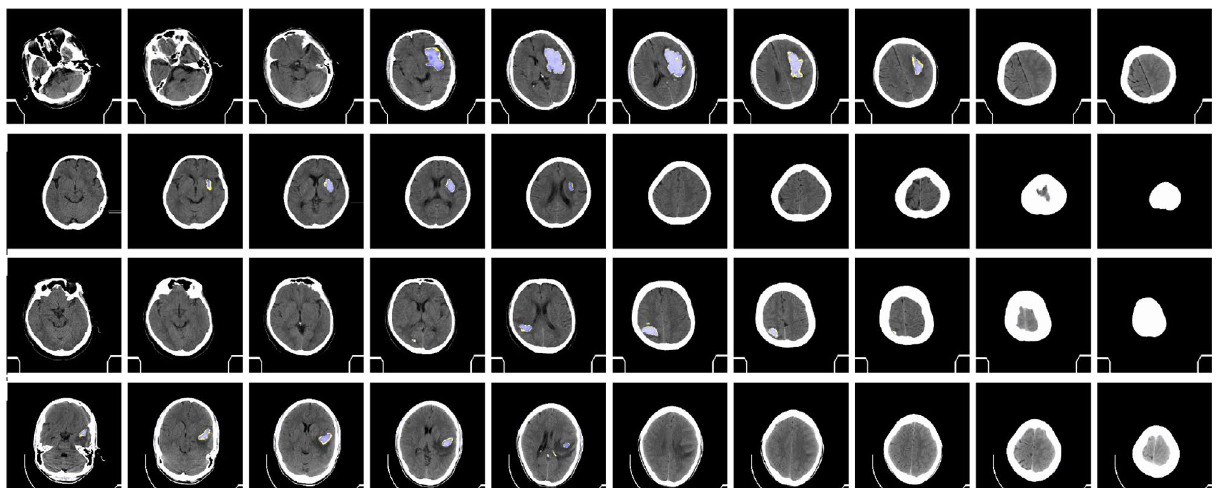
Figure 4. Samples of ICH segmentation prediction from GroupCapsNet and label hemorrhage region. (Best viewed in color and with zoom